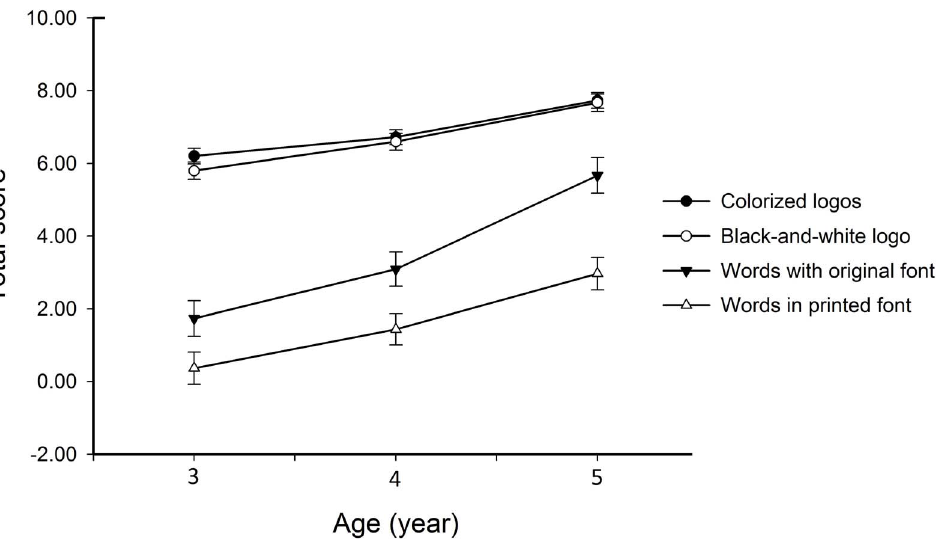
Figure 1. Total score for each version in children at ages of 3, 4, and 5. All three children groups performed better when words were presented with contextual cues than when they were presented in a plain fashion, devoid of context. However, the role of various cues changed with age increased as children read words contained in logos.